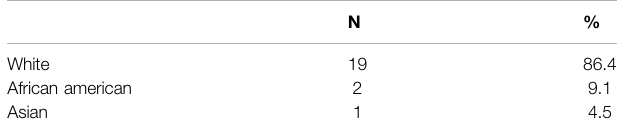
TABLE 3 | Sample demographic by ethnicity.